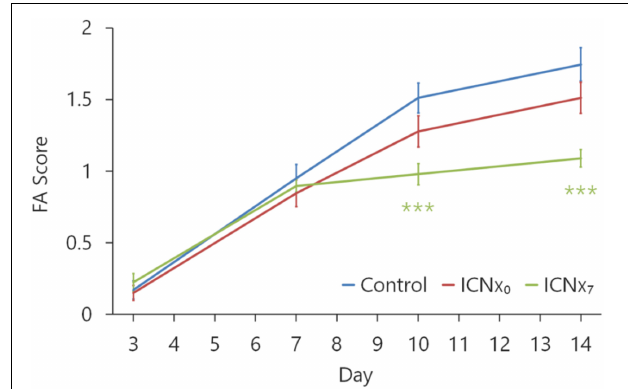
FIGURE 4 | FA scores at 3, 7, 10, and 14 days after laser injury in each experimental group ( n ≥ 45 lesions per group from six animals per group). Four laser burns were made per eye. Beginning 10 days after laser treatment, scores in the animals that underwent ICN transection on day 7 were significantly lower than scores in the animals that received sham surgery (*** P < 0.001). Error bars indicate SEM.